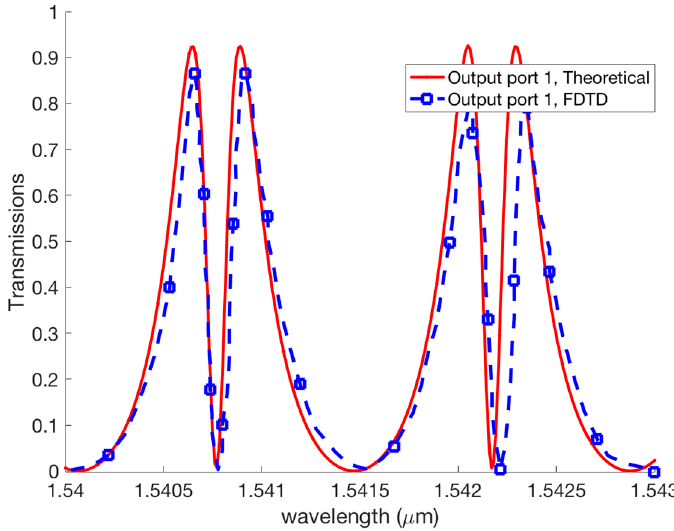
Figure 10. Comparison of theoretical and FDTD simulations.